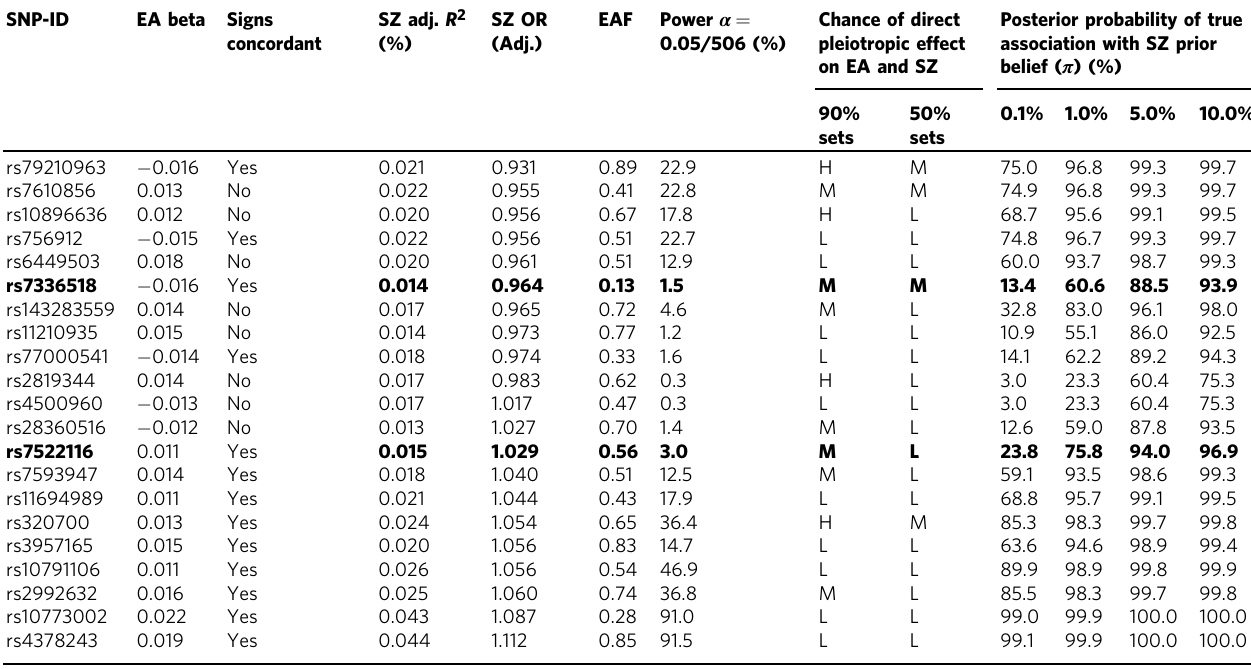
Table 1 SNPs signi fi cantly associated with schizophrenia after Bonferroni correction SNP-ID EA beta Signs